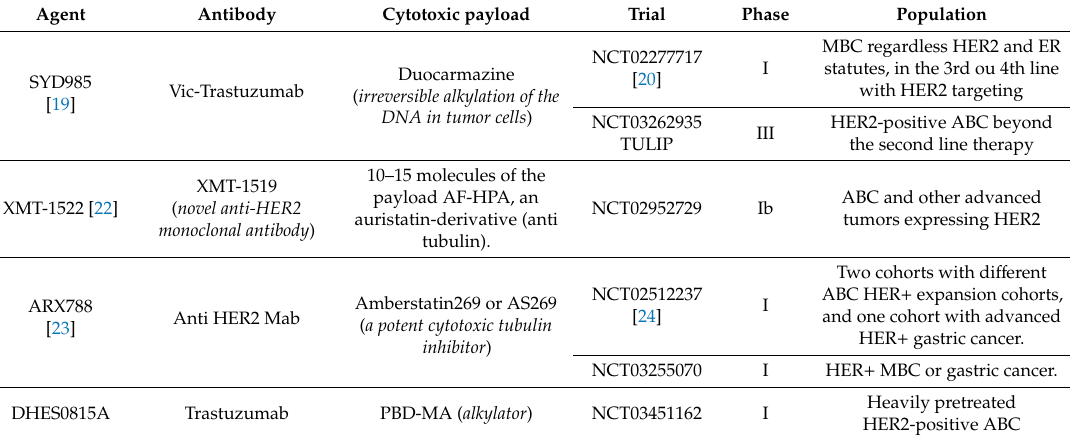
Table 2. Several new antibody-drug conjugates in development for HER2-positive